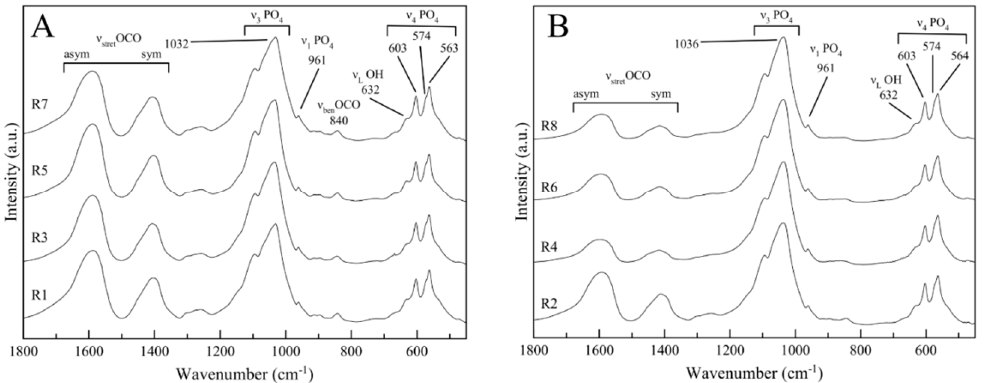
Figure 5. FT-IR spectra of the samples in the 1800–400 cm − 1 region. ( A ) Odd-numbered runs and ( B ) even-numbered runs.